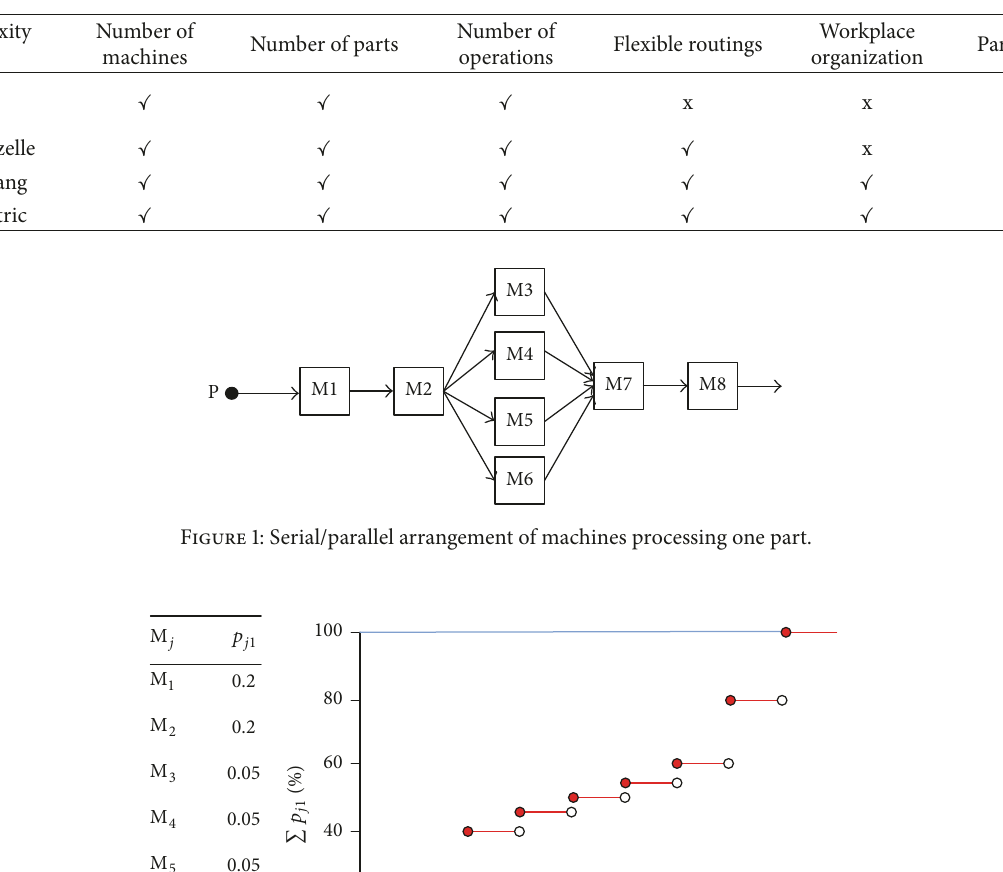
Table 1: Mutual comparison of static complexity methods.